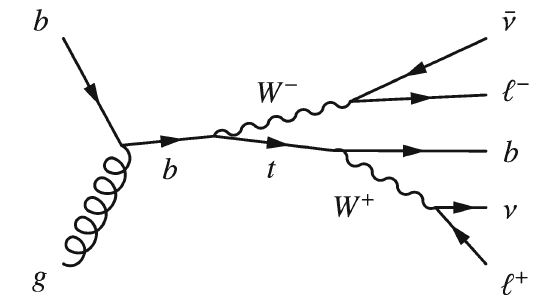
Fig. 1 A representative leading-order Feynman diagram for the pro- duction of a single top quark in the tW channel and the subsequent leptonic decay of the W boson and semileptonic decay of the top